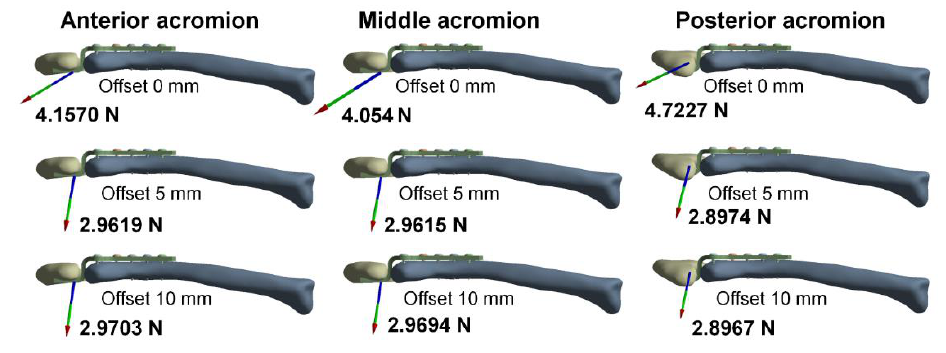
Figure 7. The distribution of von Mises stress on the clavicle.